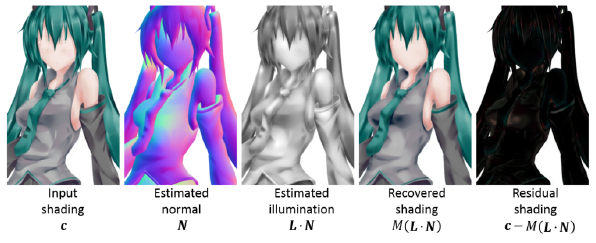
Relighting sequence using the proposed method. Non- diffuse parts are limited to static transitions with simple residual representation.